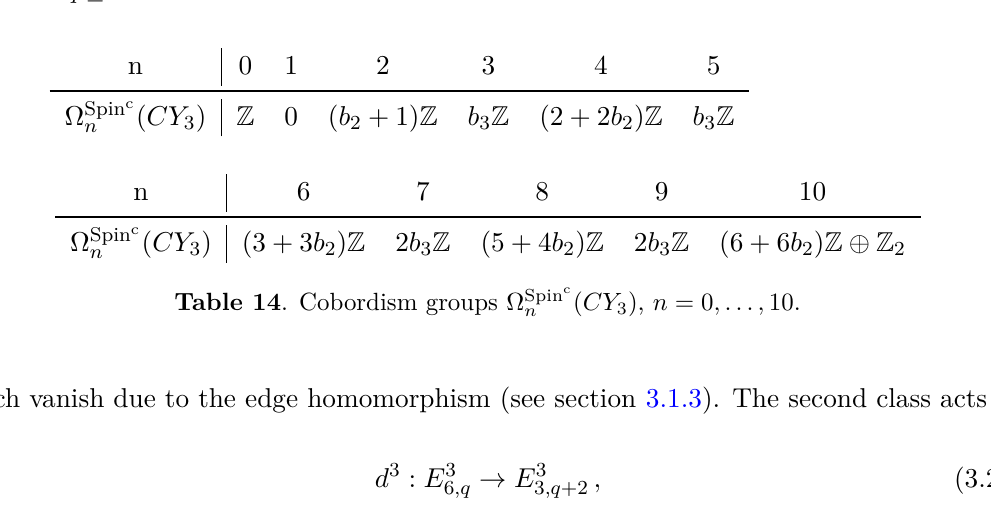
Table 13 . Second (and final) page of the AHSS for the computation of Ω Spin c possibly non-vanishing differentials d 3 : E 3 vanish for q ≤ 6 .